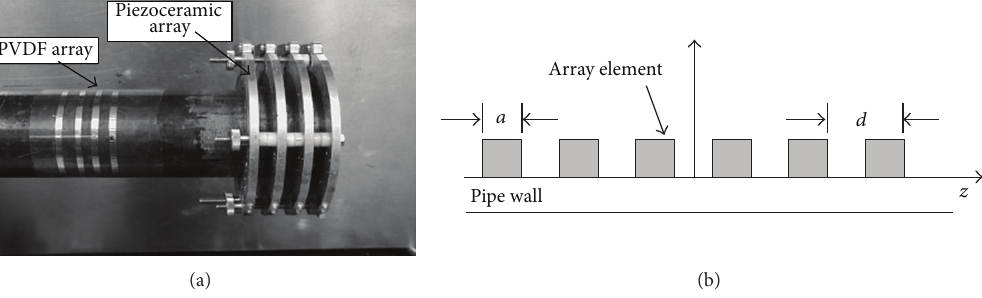
Figure 5: (a) Four-element PVDF and piezoceramic arrays and (b) array geometry [3].